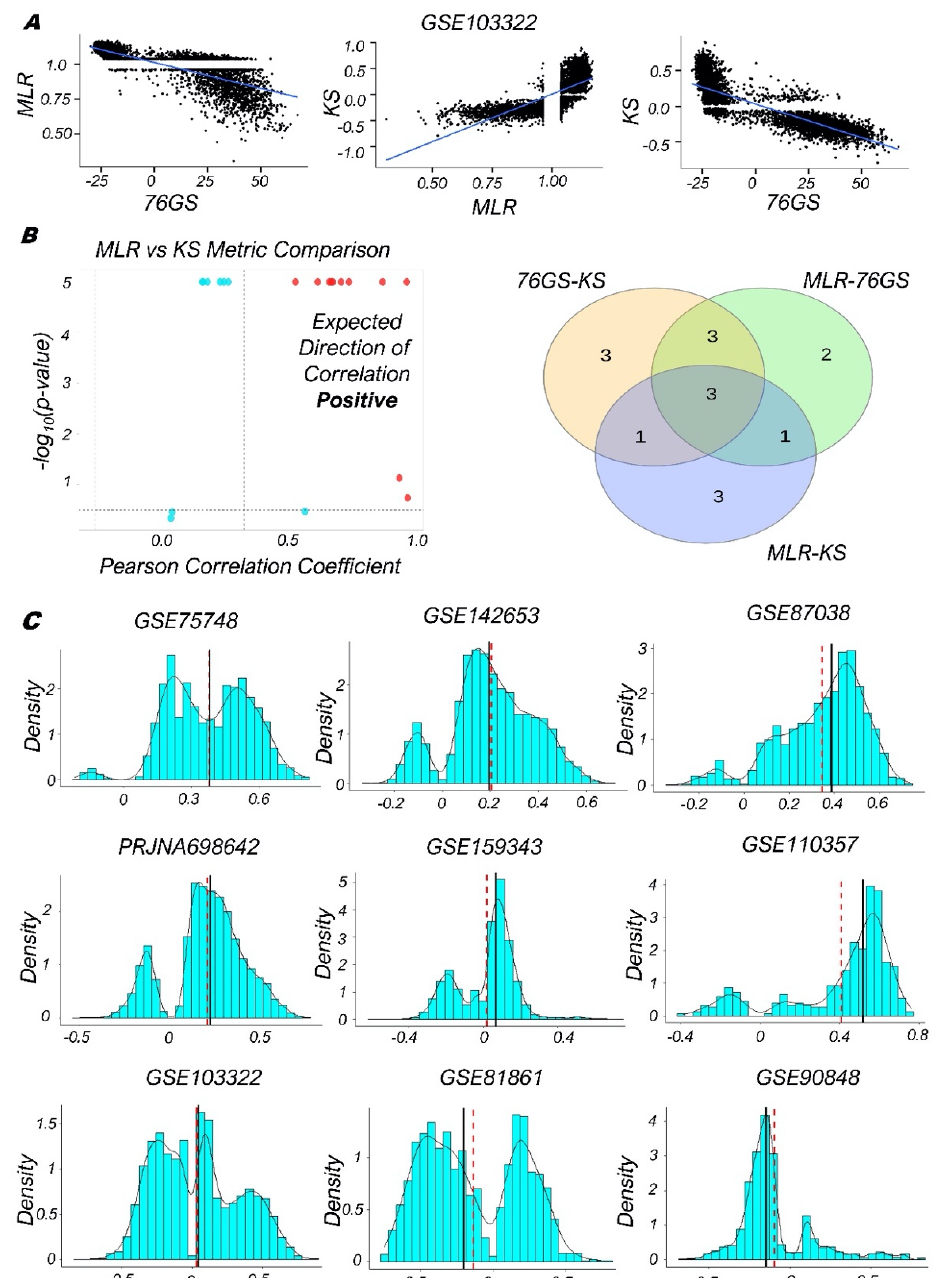
Figure 3. Concordance across EMT scoring methods in single cell RNA-Seq datasets. ( A ) Scatter plot of pairwise correlation estimated by linear regression (blue) in GSE103322 dataset. ( B ) (Left) Plots showing the correlation of MLR vs. KS EMT scoring metrics for different single-cell RNA-Seq datasets, for each sample − log 10 ( p -value) is plotted as a function of Pearson’s correlation coefficient. Thresholds for correlation ( R < − 0.3 (green points) or R > 0.3 (red points); vertical dashed grey lines) and p -values ( p < 0.05; horizontal dashed grey lines) are indicated. Cyan points denote the cases for which R > − 0.3 or R < 0.3. (Right) Venn diagram depicting the common datasets across three pairwise comparisons that are significantly correlated in the expected direction. ( C ) Histograms (teal bars) and corresponding spline interpolate density function estimates (black curves); however, the MLR scores show opposite trends than expected of KS scores in various datasets. Red dashed line and black solid line depicts mean and median,